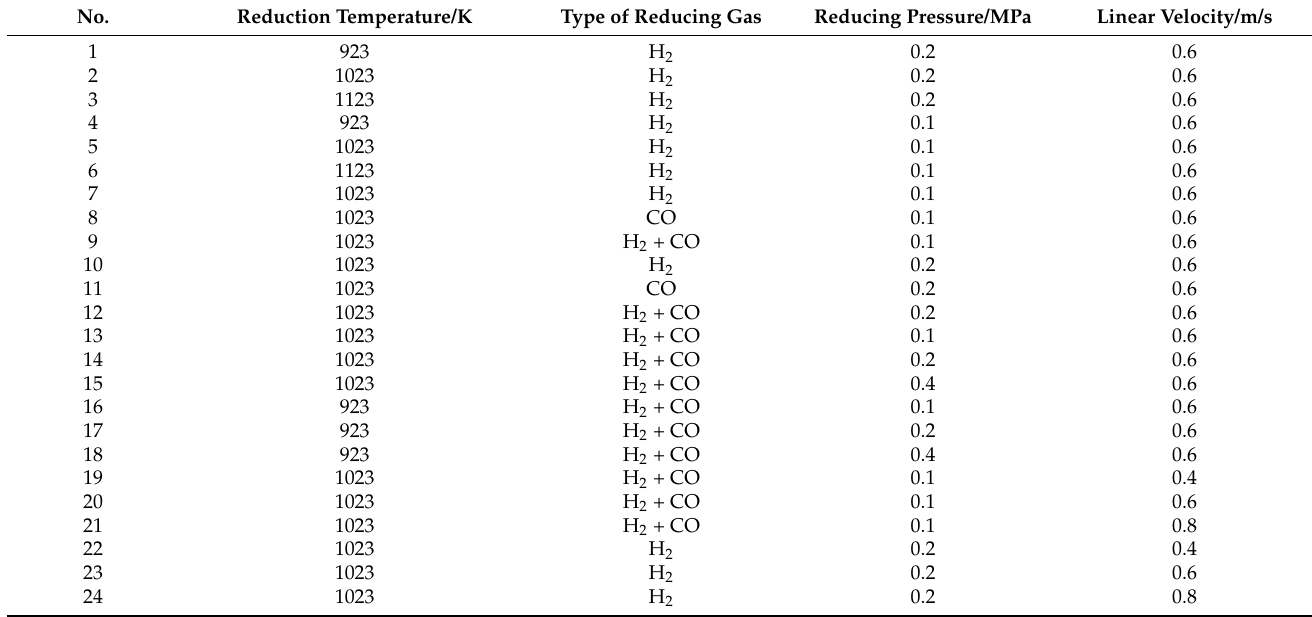
Table 1. Experimental